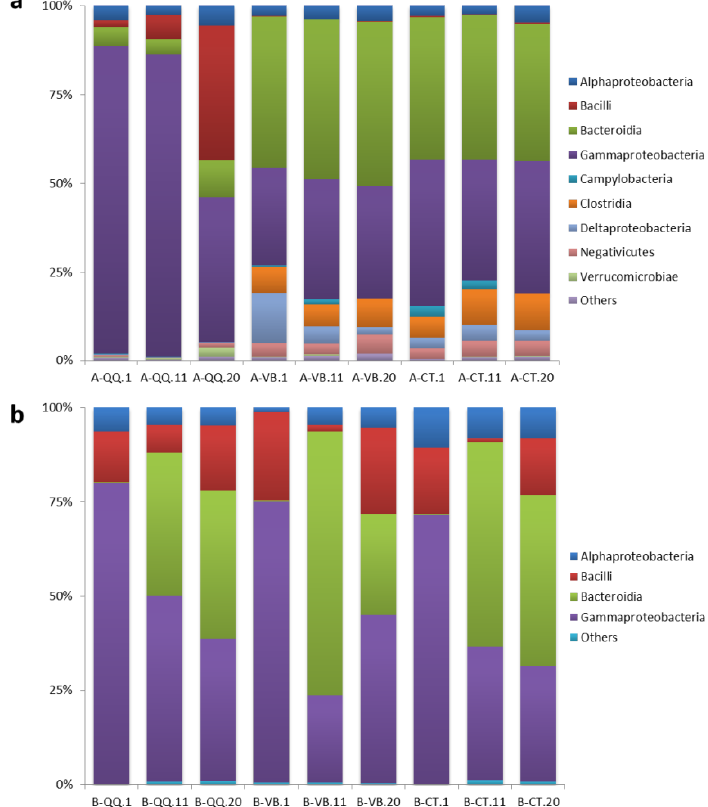
Figure 6. RA plot depicting bacteria grouped by the class taxonomic level with taxa abundance over 1%. ( a ) Activated sludge with quorum quenching (QQ) beads (A-QQ), vacant beads (A-VB), and control (A-CT), ( b ) biofilms formed on the membrane surface with QQ beads (B-QQ), vacant beads (B-VB), and control (B-CT). Numbers 1, 11, and 20 represent the sampling time in days from each bioreactor.